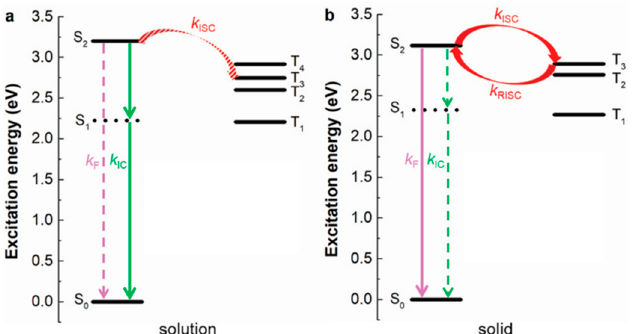
Figure 23. Adiabatic excitation energies for 94 ( a ) in THF solution and ( b ) in solid state. Adapted with permission from [82].